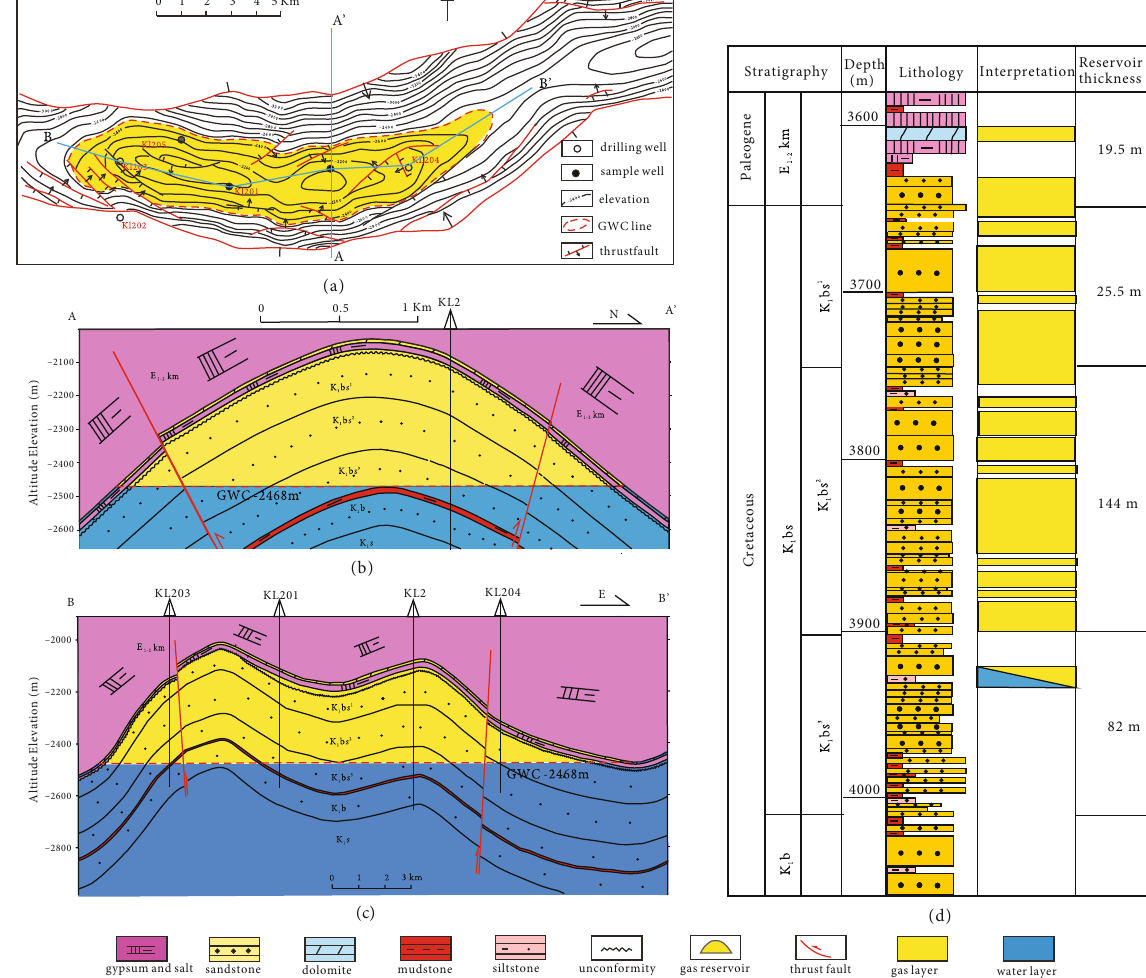
Figure 2: Map and sections showing the structure, reservoir type, and stratigraphy of the Kela-2 gas fi eld. (a) Top surface structural map of the K1bs reservoir of the Kela 2 gas fi eld. (b, c) Geological sections A – A ’ and B – B ’ showing gas reservoir type and the uni fi ed gas – water contact at an elevation of − 2468m. (d) Stratigraphy of the Kela-2 gas fi